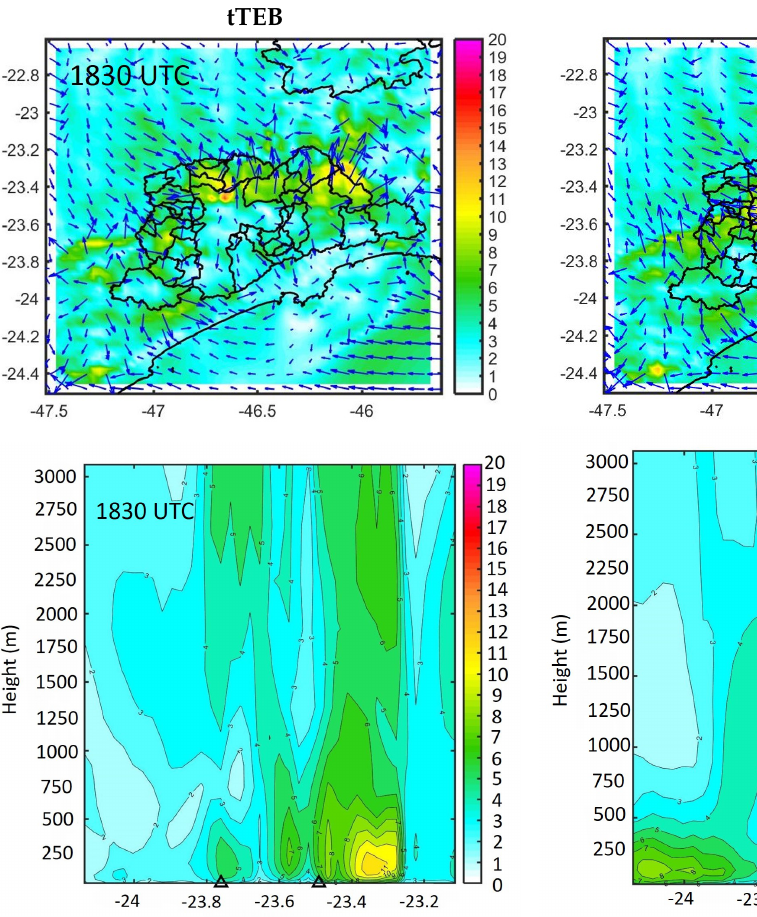
Figure 16. First row: Wind velocity vectors and wind magnitude (m s − 1 ) at the first level of the model at 1830 UTC (1530 LT). Second row: Vertical cross section of mean horizontal wind magnitude (m s − 1 ) between 46.9 ◦ W–46.42 ◦ W at 1830 UTC (1530 LT) along the latitude. The figure shows the results of tTEB experiment (first column), control experiment (second column) and the differences between both experiments (third column). Triangles indicate the extension of urban canopy of the